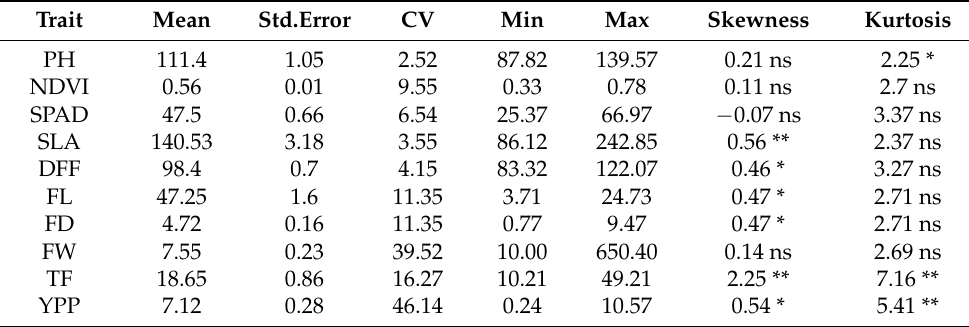
Table 5. Descriptive statistics of measured traits.